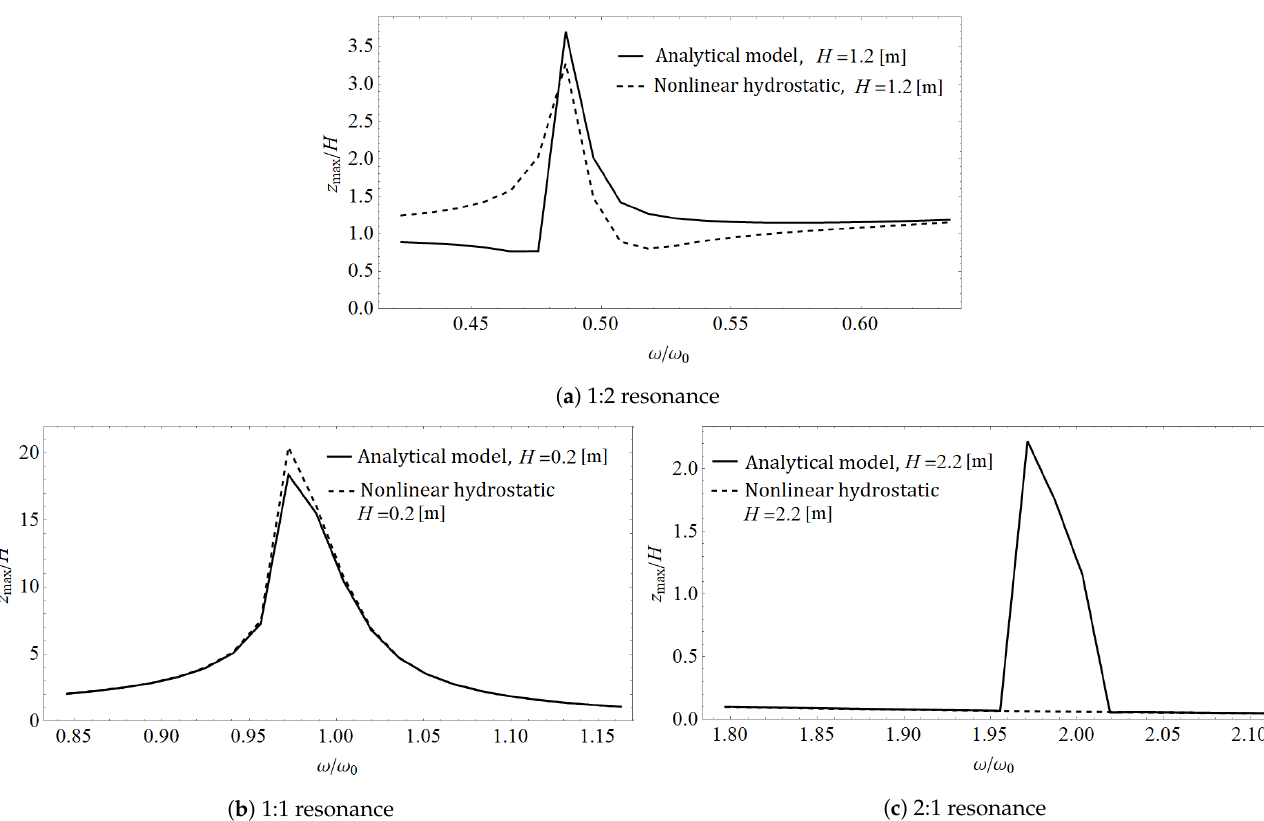
Figure 13. The normalised amplitude of the buoy oscillations as the function of wave